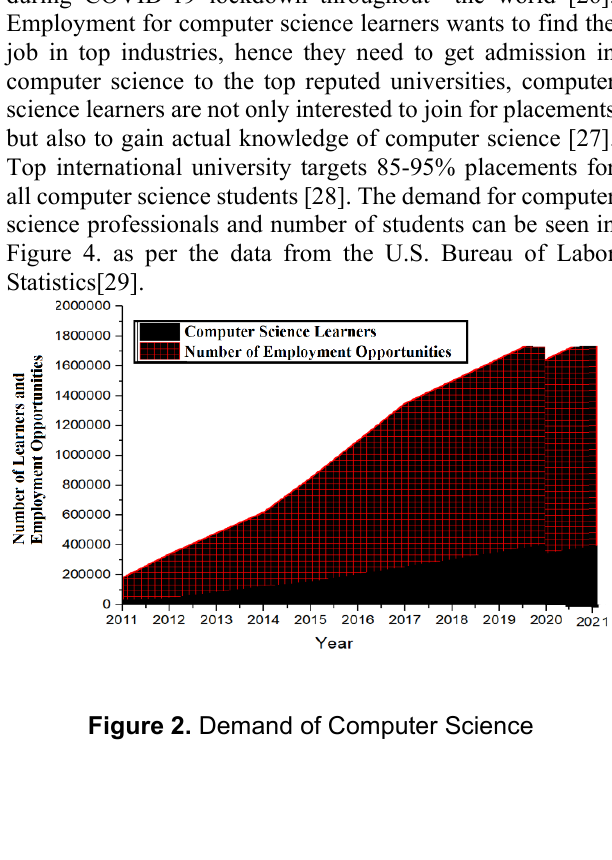
Figure 1. Flipped class room during lockdown